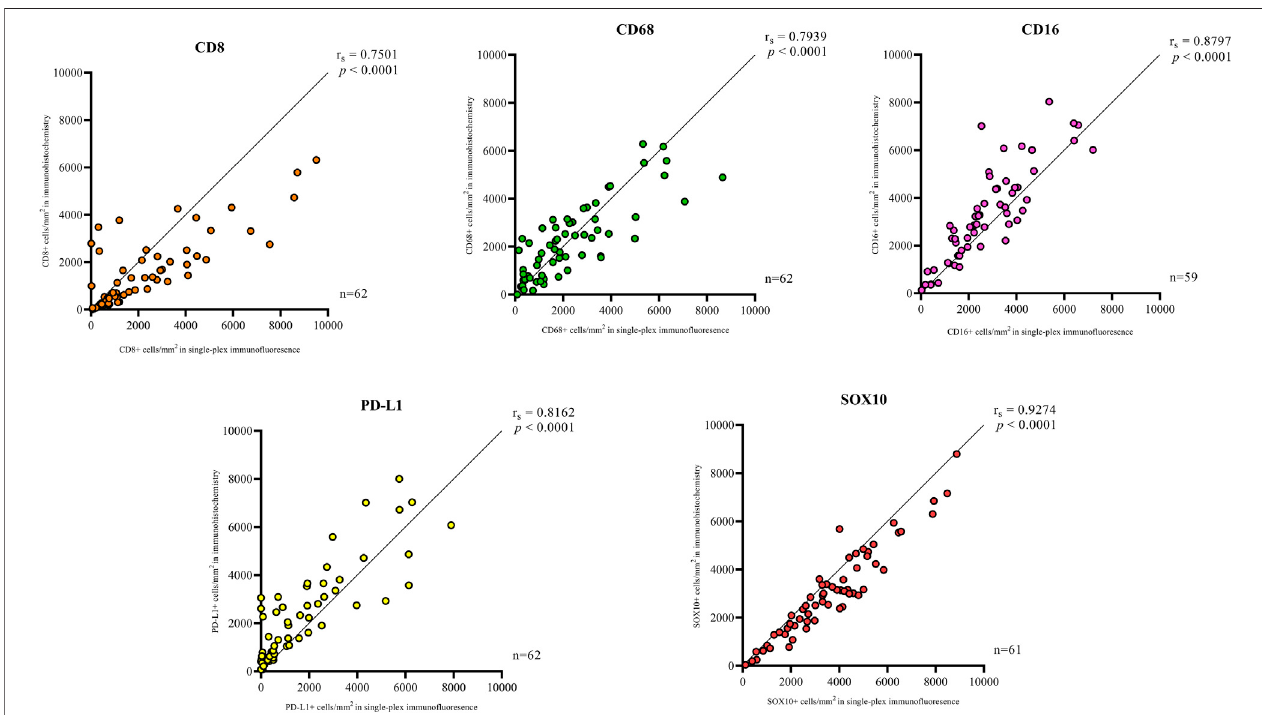
FIGURE 3 | Correlation plots represent the correlation between the density of positive cells in traditional chromogenic immunohistochemistry and single-plex immuno fl uorescence for each marker in represented. Correlation analysis between the cell densities for each marker showed signi fi cant positive correlations. The strongest correlations were observed in CD16 ( n = 59) and SOX10 ( n = 61). The lowest correlations were observed in CD8 ( n = 62). Data are Spearman ’ s correlation values with p <